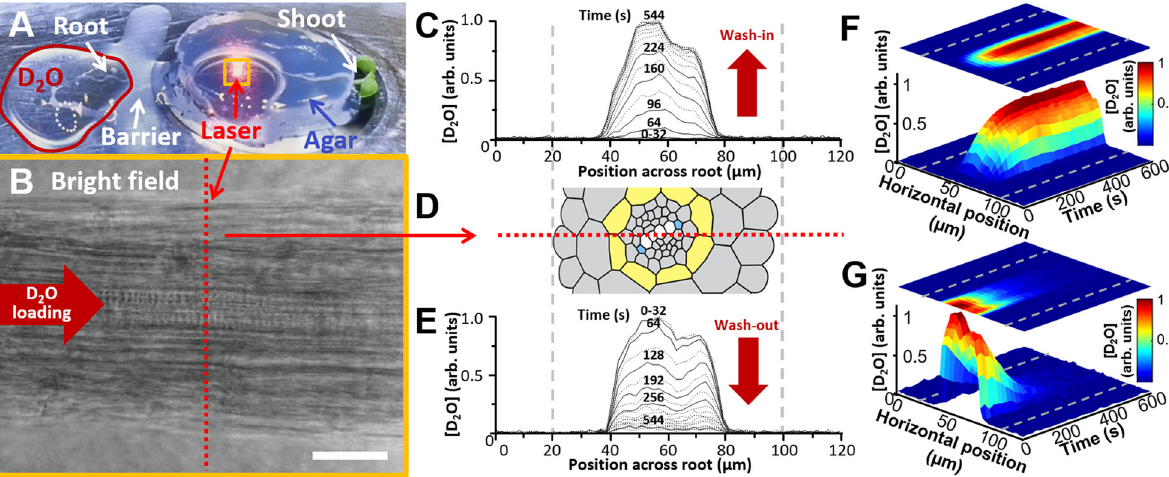
Fig. 1 Overview of the water imaging system and its outputs in line-scan mode. A Experimental setup for imaging hydrodynamics, showing A. thaliana under Raman measurement (laser). D 2 O loaded via the intact root tip is separated from the rest of the plant by a silicone grease barrier. The H 2 O-containing agar cap placed over the root prevents movement and desiccation. The location of panel B is indicated by the orange box. B Bright- fi eld micrograph of intact root (scale bar 25 µ m). The dotted red line indicates the location of line scans in ( C – G ). Note the visible xylems in this central plane of focus. C Time-course of D 2 O wash-in during successive line scans across the root center. Timings (in seconds) de fi ne the start of each line scan. D Root anatomy, showing the location of the confocal RMS line scan ( C , E ) across the full diameter, through the slightly tilted stele, with highlighted endodermis (yellow), protoxylem vessels (blue), and immature xylem (white). Spatial resolution is diffraction-limited at a 2 µ m step size, temporal resolution is 300ms/point (detector limit). E Time-course of D 2 O wash-out during successive line scans. Timings (in seconds) de fi ne the start of each line scan. F 3D plot showing spatiotemporal dynamics of D 2 O pulse arrival at the line under observation. G 3D plot showing spatiotemporal dynamics of D 2 O washing out of the preparation when H 2 O is re-introduced via the intact root. Spatial resolution is diffraction-limited at a 2 µ m step size. Temporal resolution is 300ms/point (detector limit). Dotted gray lines in C – G indicate the outer boundary of the root under observation. Source data underlying Fig. 1C, E – G are provided as a Source Data fi